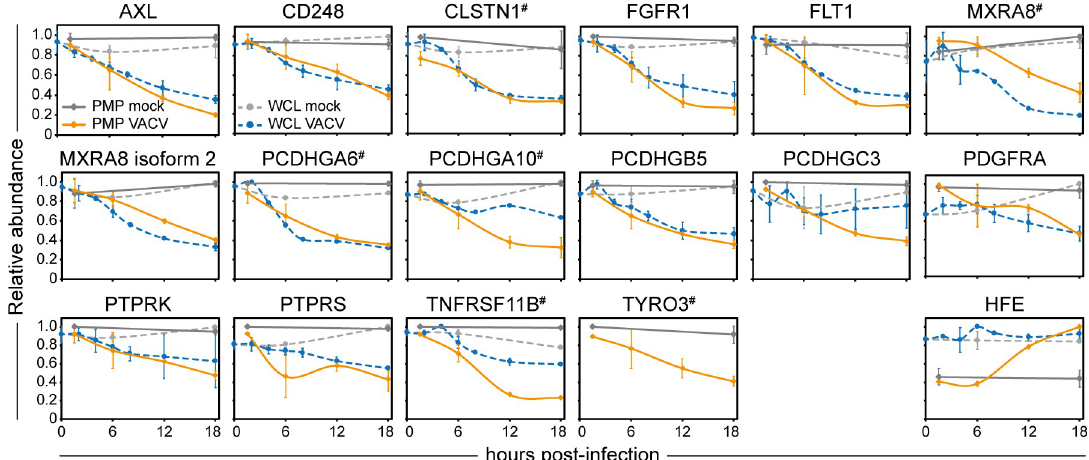
Fig 5. Modulation of surface expression of putative immune ligands during VACV infection. Temporal profiles of selected putative immune ligands modulated during VACV infection (S3 Table). Data are represented as mean ± SD (PMP n = 2; WCL n = 3 [9], # WCL < n =